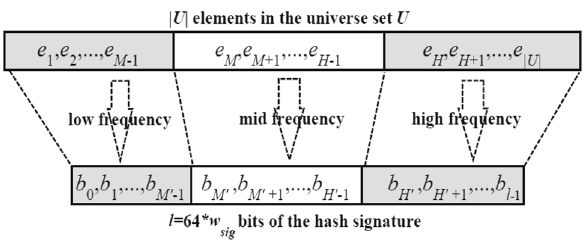
Fig. 3 Illustration of basic idea in hash method